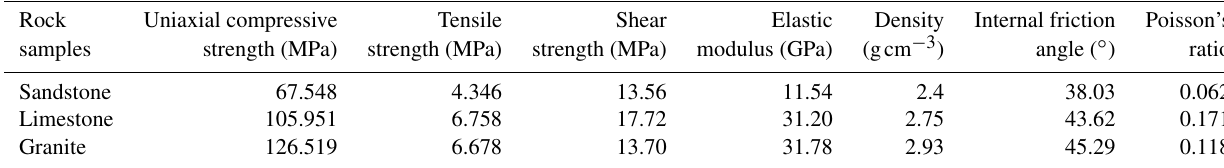
Table 2. Properties of 63# matrix material. HRC Flexural Density Hot pressing Impact strength (MPa) (gcm − 3 ) temperature ( ◦